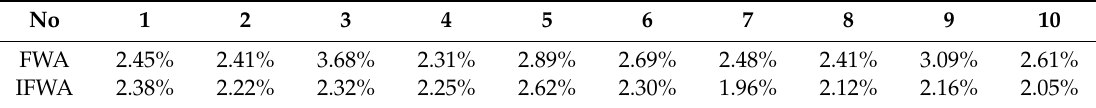
Table 10. The comparison of relative error.